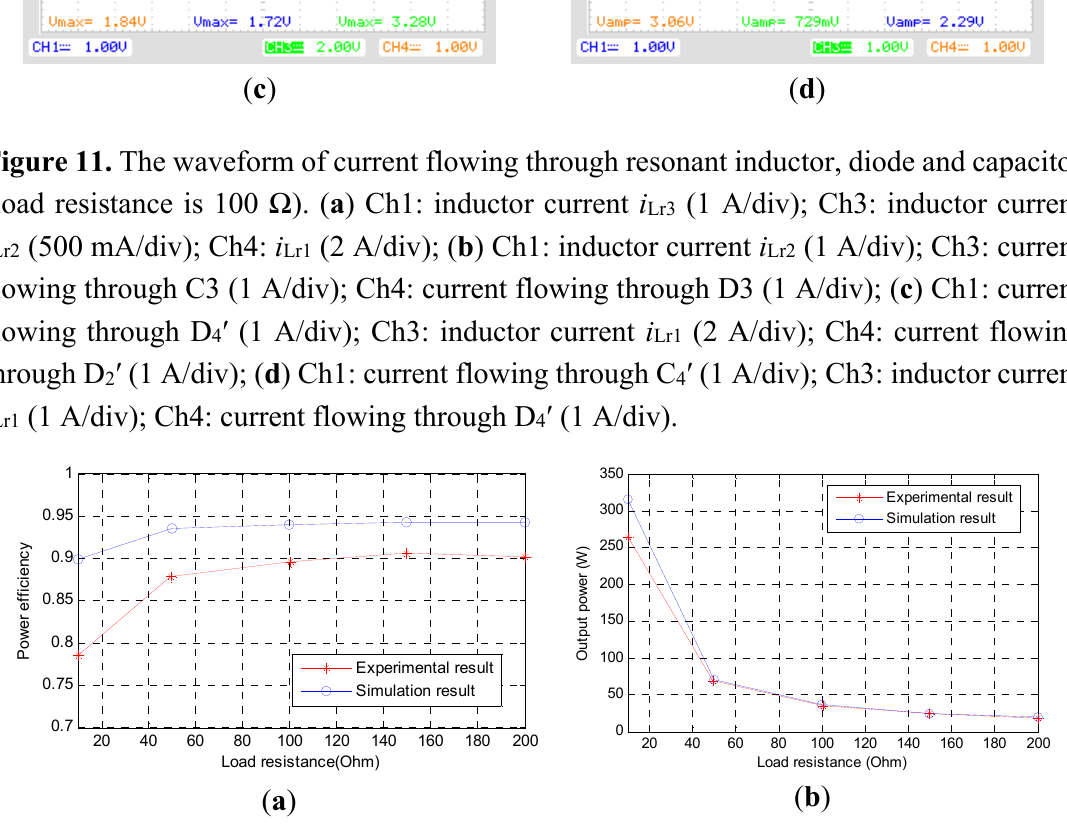
Figure 12. Simulation and experimental results for power efficiency and output power of the proposed circuit: ( a ) simulation and experimental results for power efficiency; and ( b ) simulation and experimental results for output